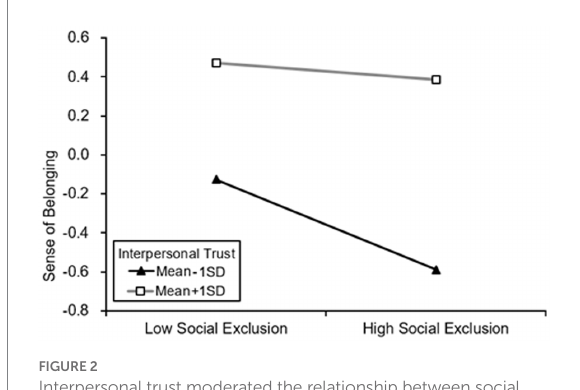
FIGURE 2 Interpersonal trust moderated the relationship between social exclusion on sense of belonging.